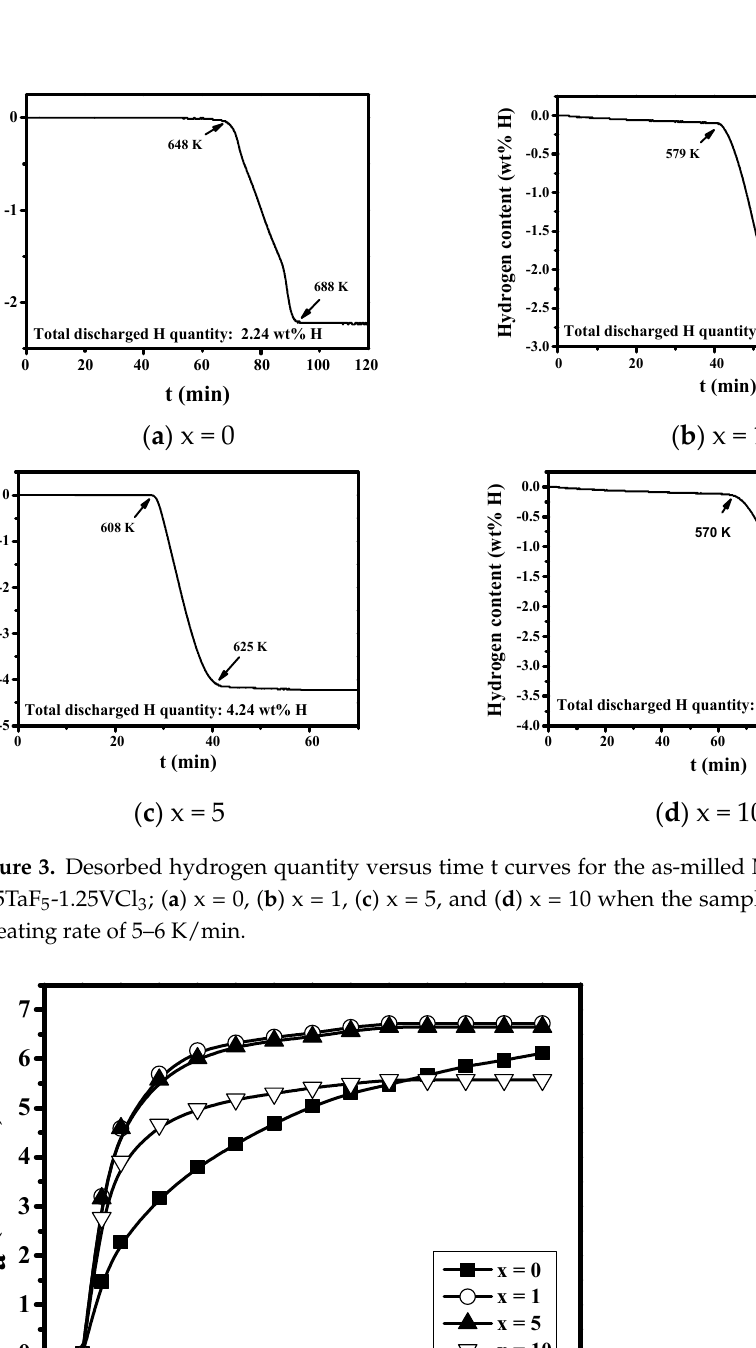
from 6.12 wt% H (x = 0). Mg-1MgH 2 -1.25Ni-1.25TaF 5 -1.25VCl 3 absorbs 3.20 wt% H for 2.5